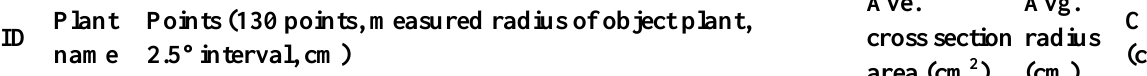
Table 5. Data samples measured by the proposed measurement method (rotary-type). ID